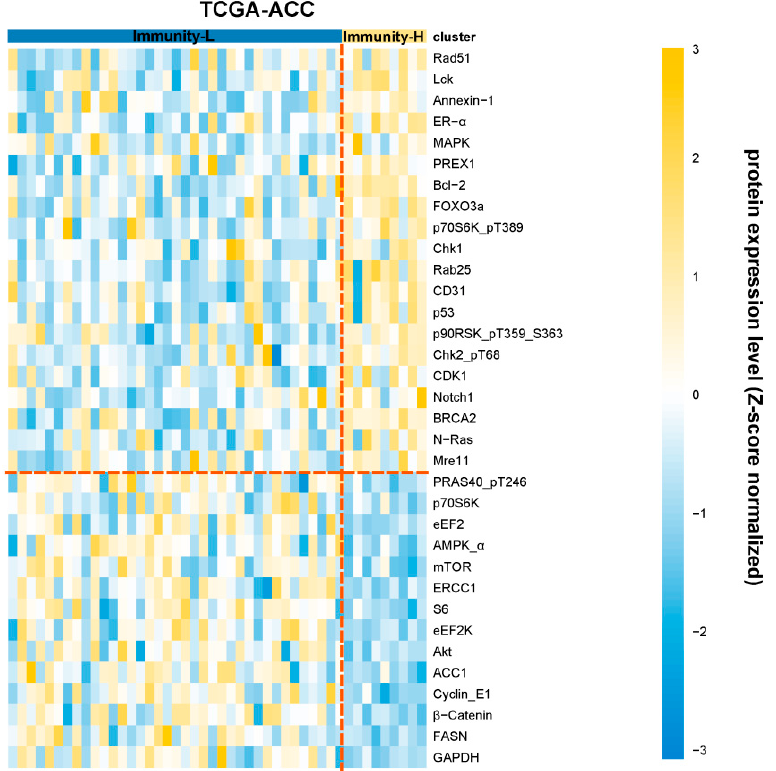
Figure 5. Differently expressed proteins between the immune subtypes of ACC. Heatmap showing the proteins with significant expression differences between Immunity-H and Immunity-L in TCGA-ACC (two-tailed Student’s t test, FDR < 0.05). ACC (two-tailed Student’s t test, FDR <